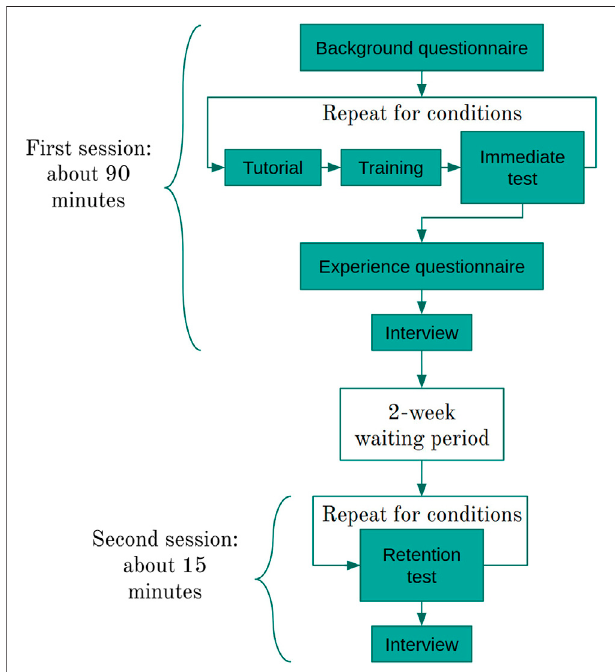
FIGURE 5 | Overview of the experiment